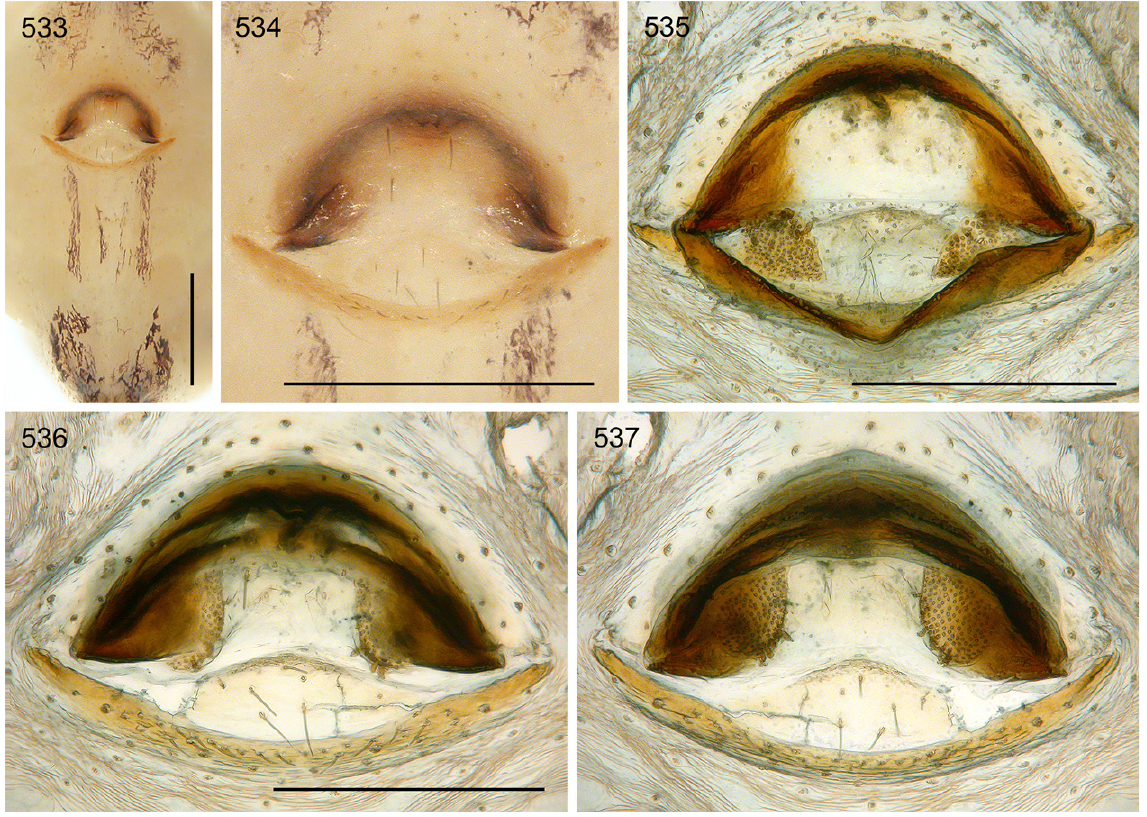
Figs 533–537. Crossopriza ghul sp. nov.; female from Oman, Wadi Ghul (ZFMK Ar 22428). 533– 534 . Abdomen and epigynum, ventral views. 535–537 . Female internal genitalia, dorsal view (with dorsal arc tilted backwards), ventral view, and regular dorsal view. Scale bars: 533–534 = 0.5 mm; 535–537 = 0.3